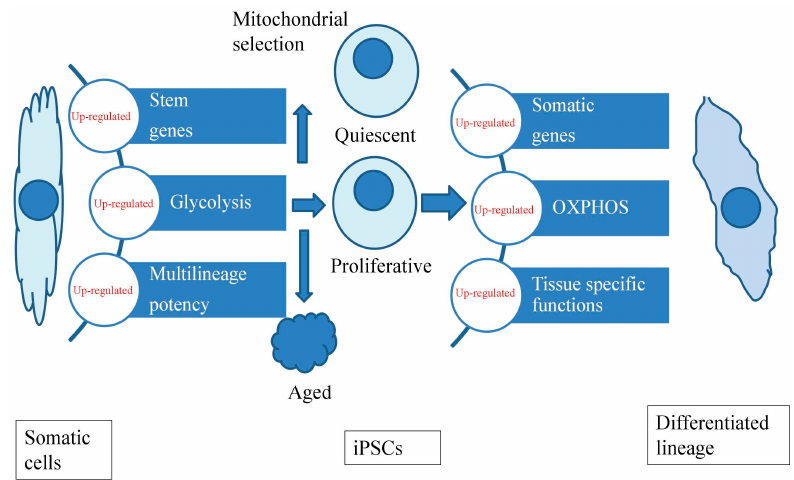
Figure 2. Successful reprogramming is always accompanied by a metabolic shift from a pro-oxidative state to glycolysis, and it will conversely shift after differentiation.